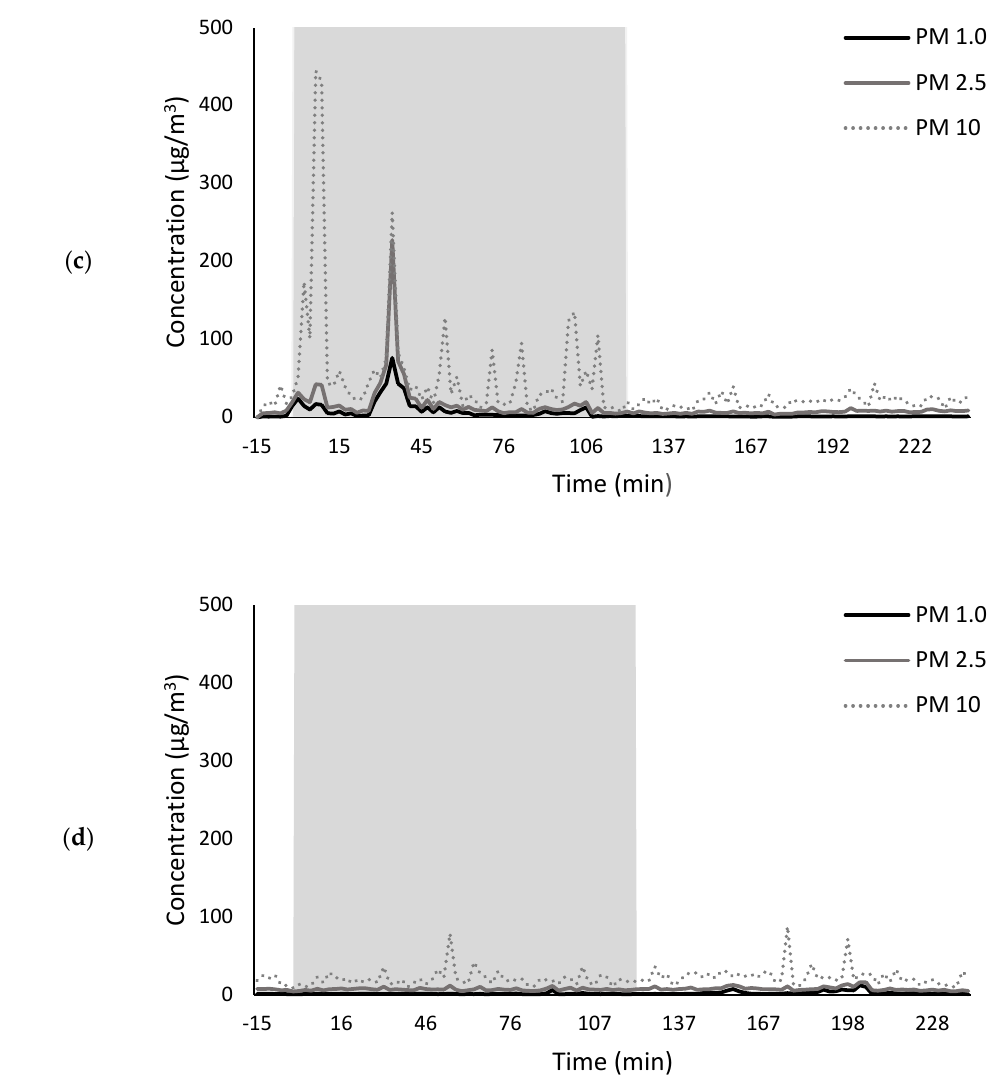
Figure 4. Environmental conditions before, during (shaded) and after pea stubble burn: ( a ) wind and gust speed, and air temperature, measured amongst the stubble windrows; and particulate matter (PM) concentrations, measured ( b ) amongst stubble windrows in a pea field, ( c ) on the edge of the pea field (downwind) and ( d ) in an adjacent field (approximately 500 m downwind).